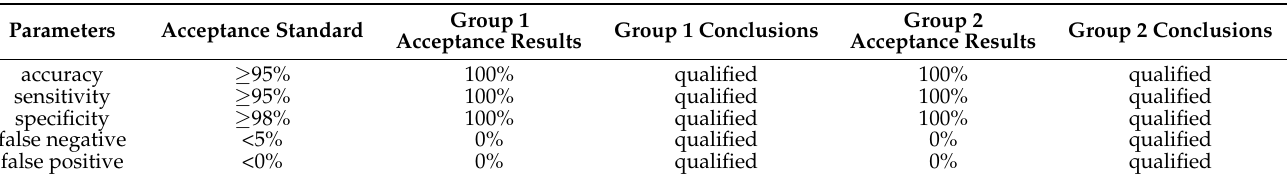
Table 1. Acceptance results of two groups obtained using national standard method and microbial photoelectric detection system.